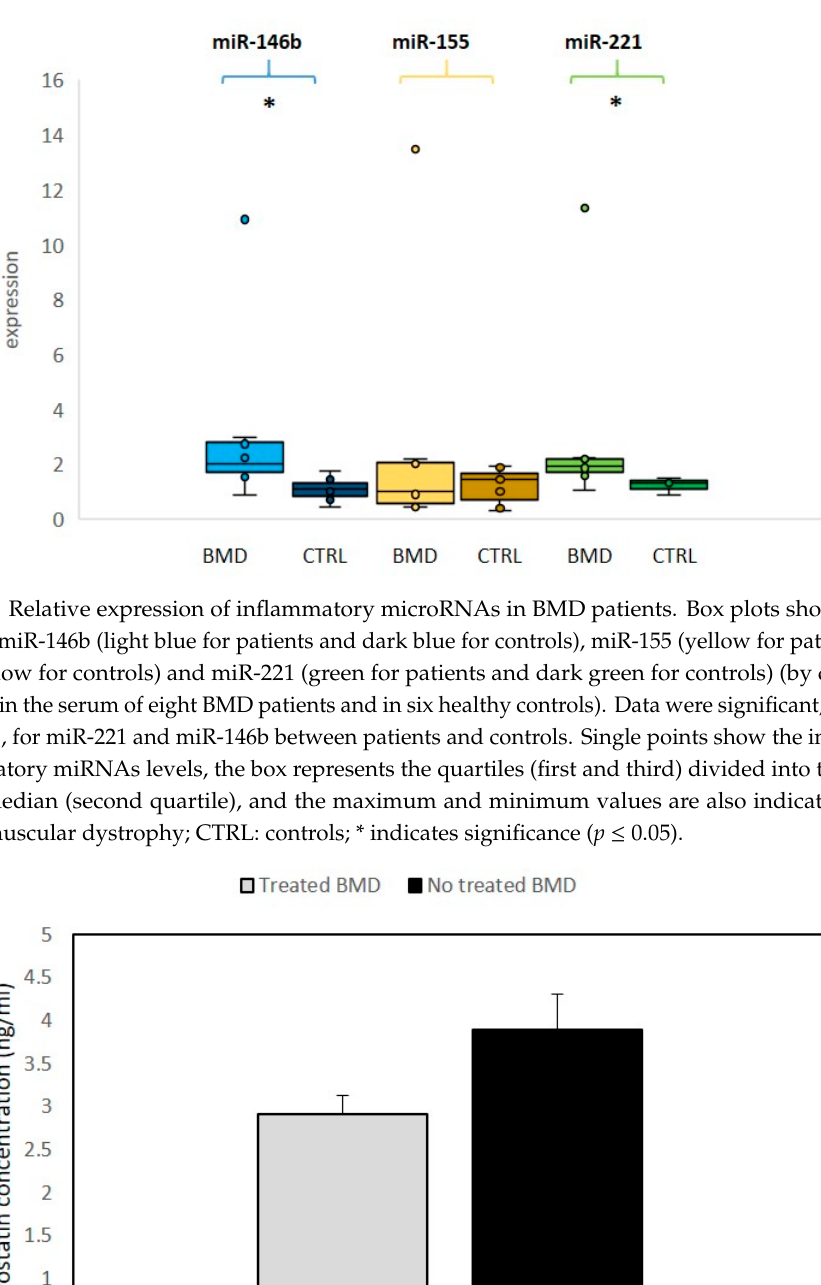
Figure 3. Histogram showing the concentration of myostatin in BMD patients. Quantitative myostatin expression was compared between treated ( n = 2) and untreated BMD ( n = 6) patients using the ELISA test. Data are expressed as mean + standard deviation.